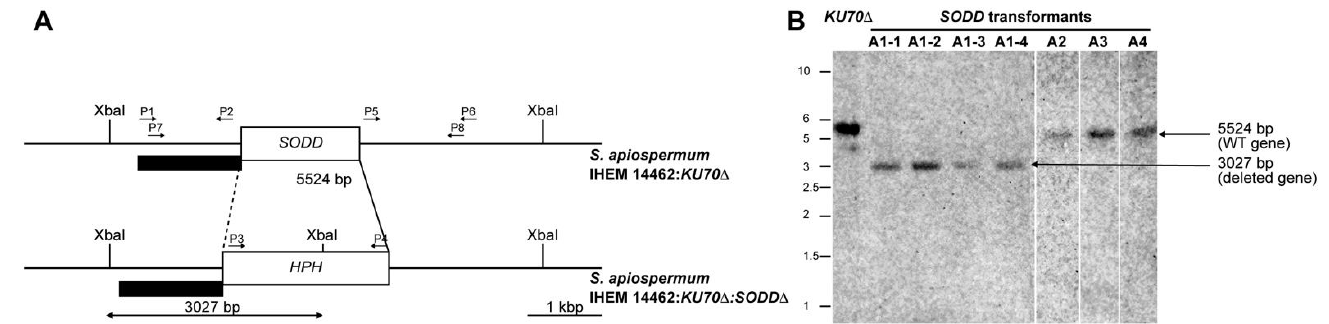
Sequences that are indicated in bold font correspond to homologous sequences overlapping with the resistance marker.